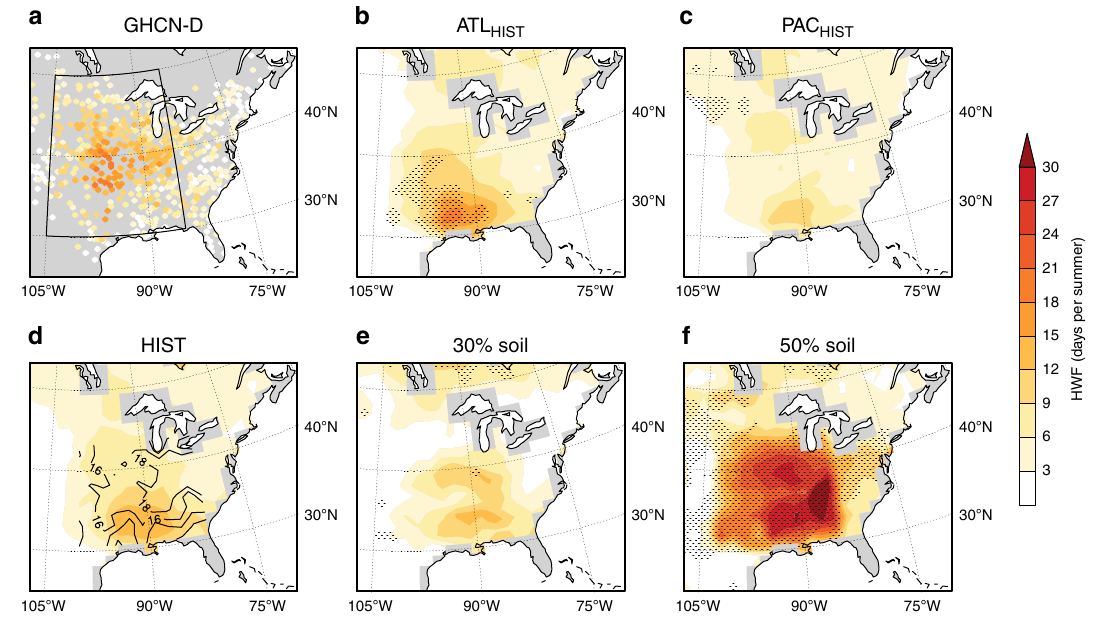
Fig. 2 Observed and simulated summer heatwave frequency during the Dust Bowl. Average heatwave frequency (HWF) over the central US for 1930 – 1937, for observations from Global Historical Climatology Network-Daily (GHCN-D; a ), and Hadley Centre Global Environment Model version 3 (HadGEM3) simulations, including a fi ve-member Atlantic sea surface temperature (SST) ensemble (ATL HIST ; b ), fi ve-member Paci fi c SST ensemble (PAC HIST ; c ), ten-member historical SST ensemble (HIST; d ), and single-model experiments where the amount of bare soil in 1930, averaged over the central US, was increased from 15 to 30% ( e ) and 50% ( f ). Stippling indicates signi fi cantly larger HWF values between ( b , c ) ATL HIST and PAC HIST ensembles ( N = 40) at the 95% con fi dence level (see ‘ Methods') 28 , and in ( e , f ) HWF values outside the HIST simulation range. Contours in ( d ) indicate the percentage of bare soil in each grid cell over the most active heatwave region in the HIST, ATL HIST and PAC HIST members. The climatology period